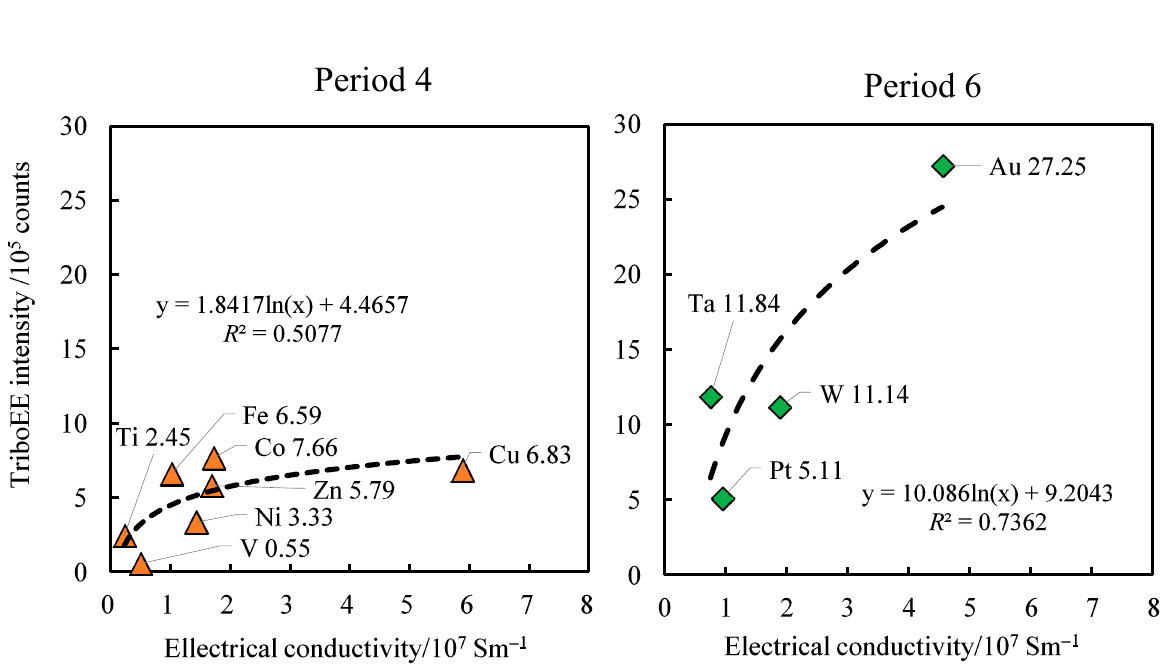
Figure 12. The plots of TriboEE intensity against electrical conductivity for metals in groups 10 and 11 (above), and periods 4 and 6 (below).